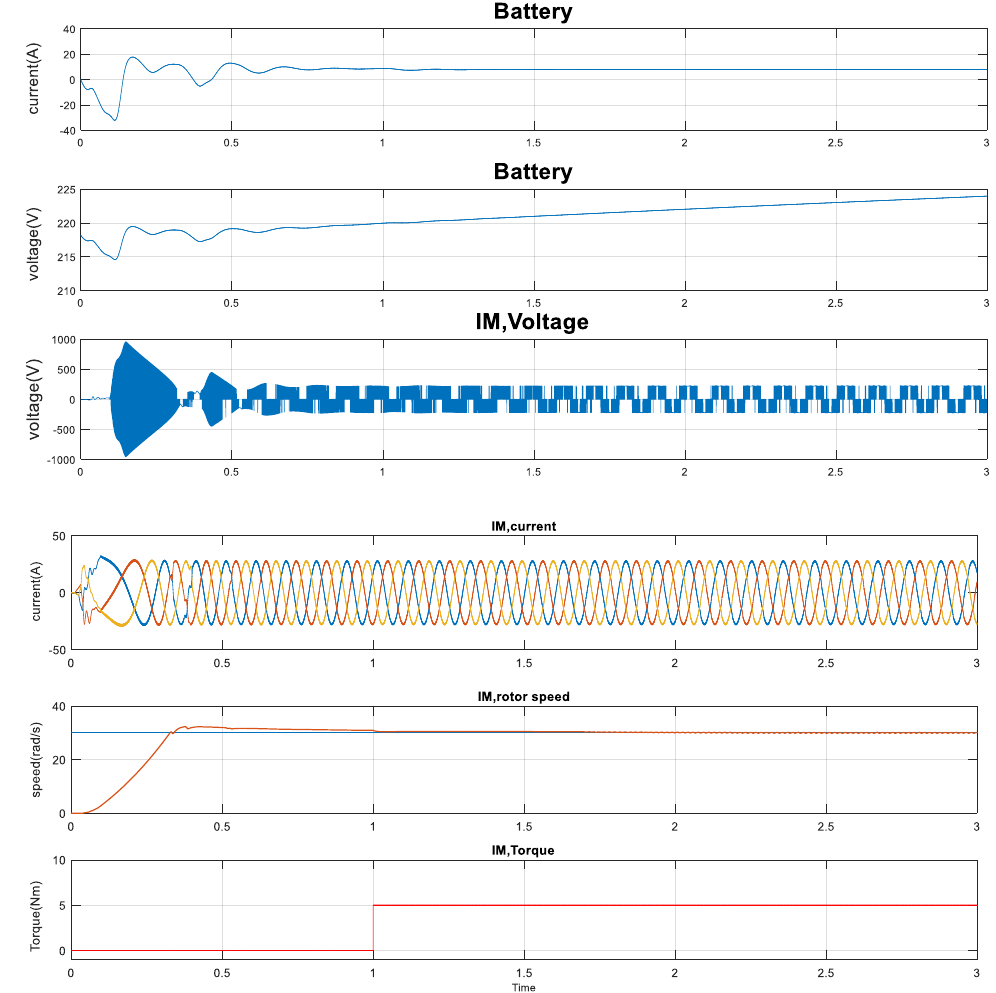
Figure 6. E ff ective reaction of autonomous wind / storage production component providing IM when Figure 6. Effective reaction of autonomous wind/storage production component providing IM when the suggested control for step changes in velocity of IM load the suggested control for step changes in velocity of IM load torque.